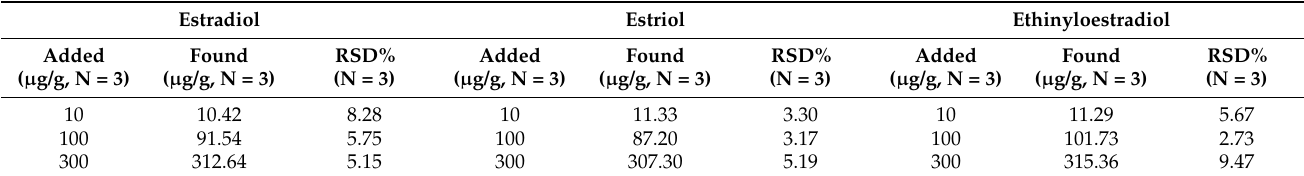
Table 1. The results of detection samples with complex